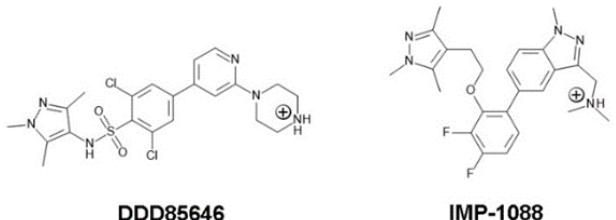
Figure 1. 2D structures and protonation states of the NMT inhibitors, DDD85646 and IMP-1088, at a pH of 7.0. Both molecules have a net charge of +1 due to protonation of the piperazine ring of DDD85646 and the dimethylamino group of IMP-1088.